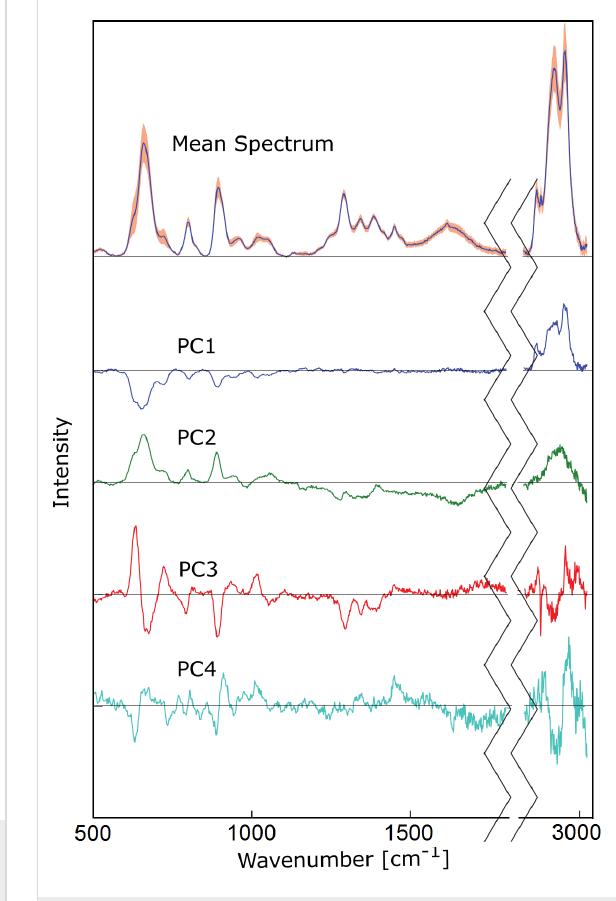
Figure 4: First four principal components used for the support vector machine model. These loadings represent 89% of data variance be- tween MCF-7, Capan-1, SK-Hep1 and HepG2 cell lines.